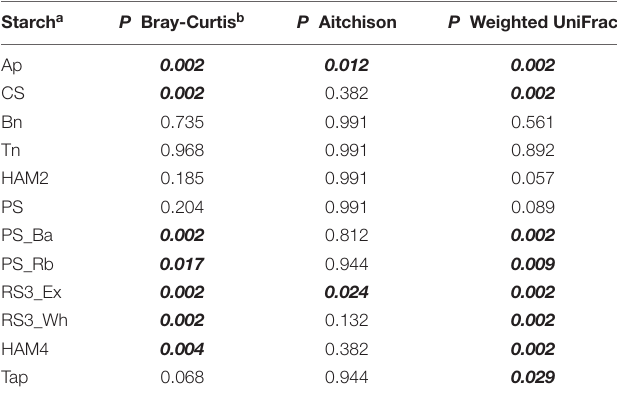
TABLE 2 | PERMANOVA results comparing beta diversity metrics between treatments and control. Starch